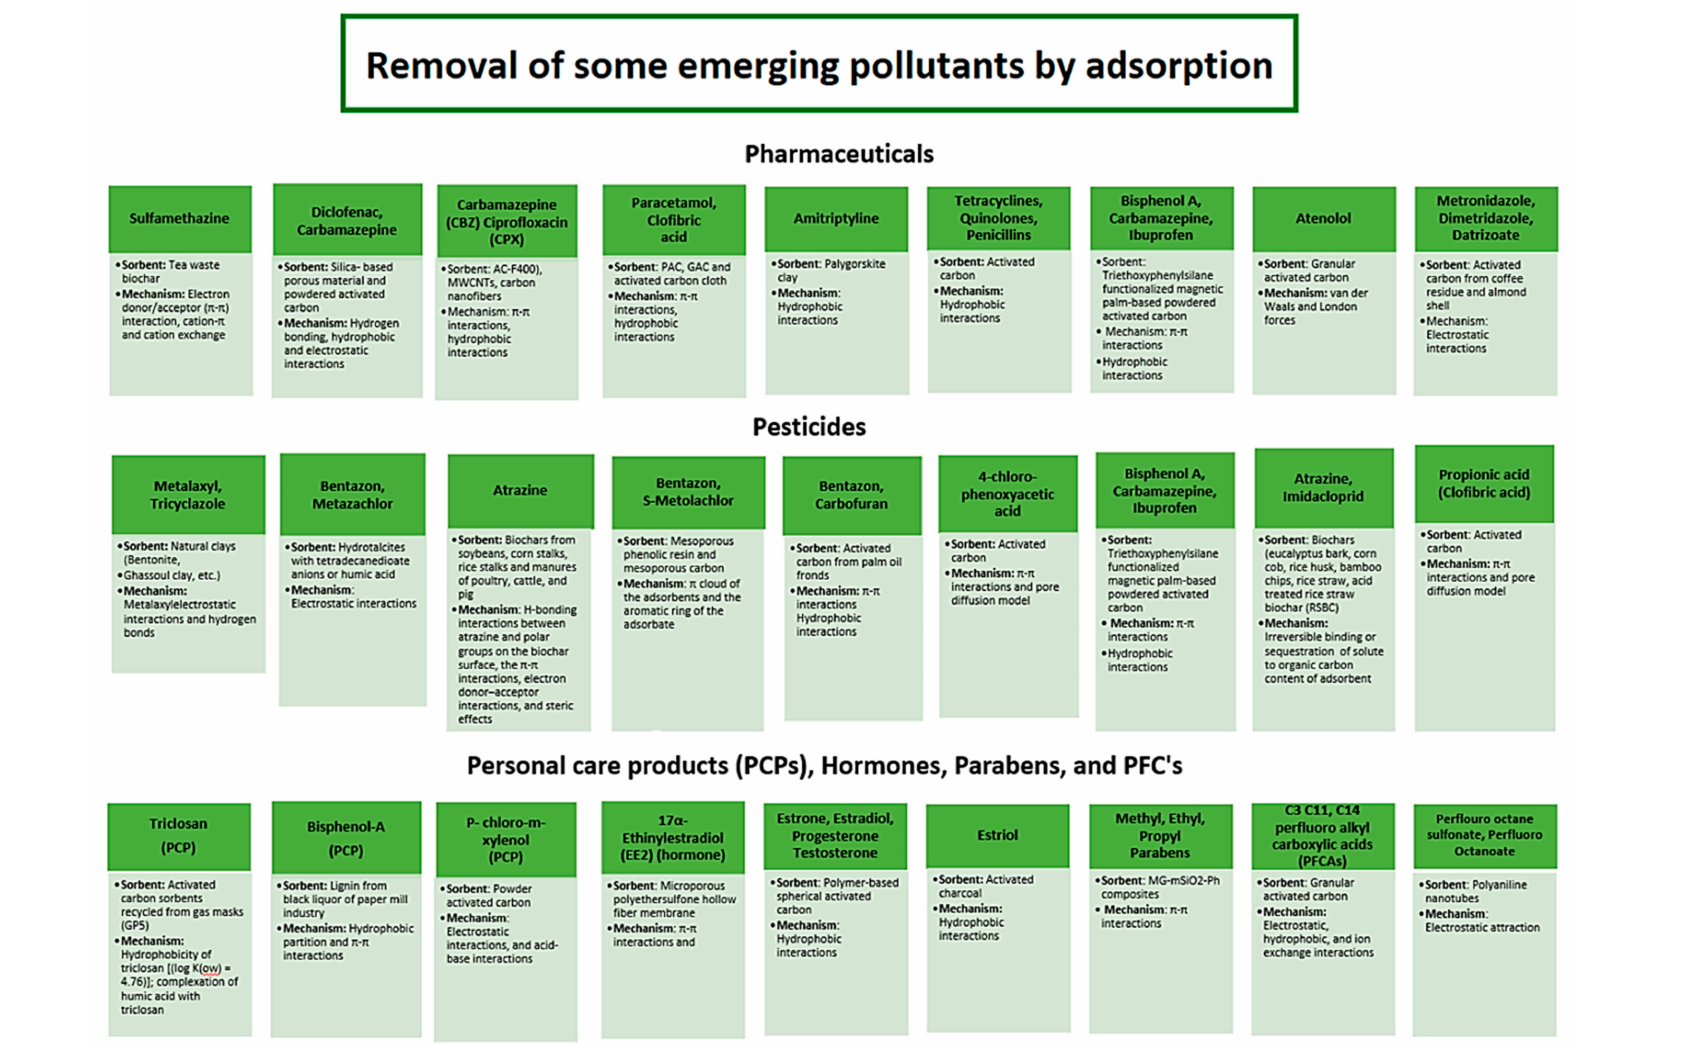
Figure 10. Sorbents and mechanisms for the removal of some emerging pollutants from the environment (adapted upon